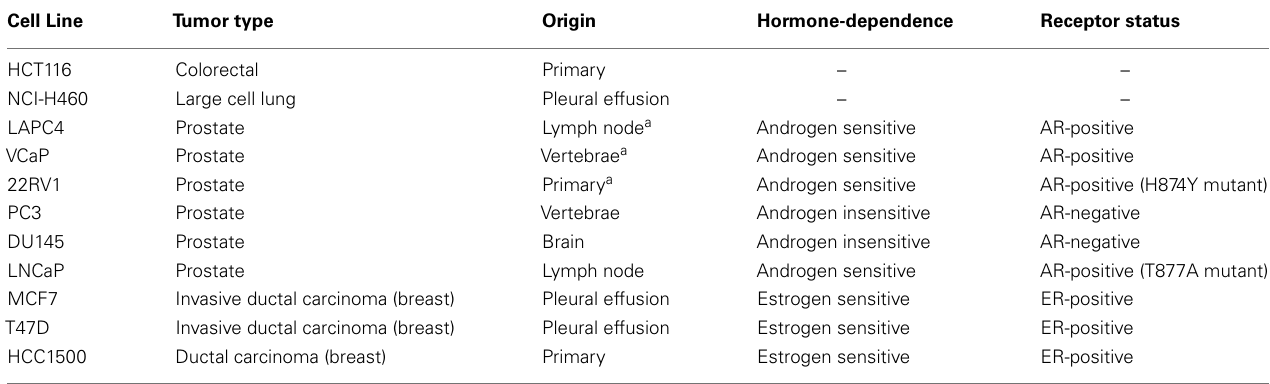
Table 1 | Cell line type, hormone-dependence, and receptor status